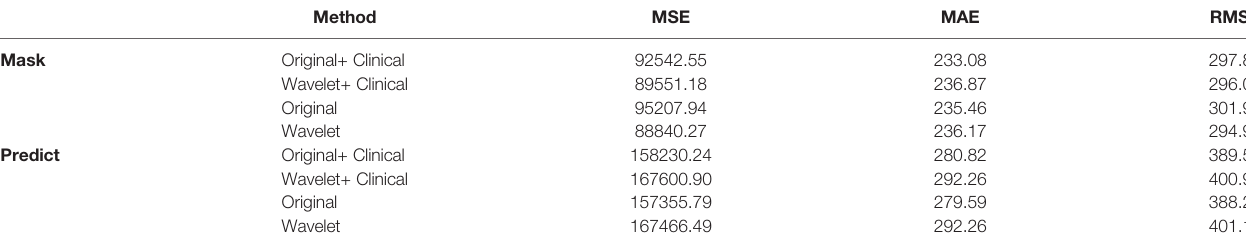
TABLE 6 | Survival prediction results of different radiological features on BraTS